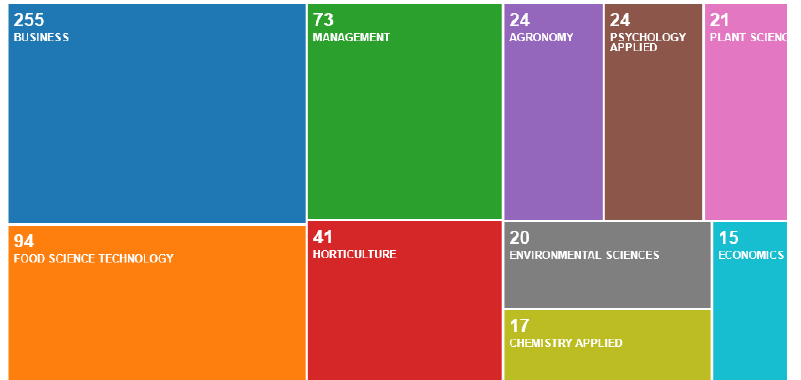
Figure 2. Treemap of literature pertaining to aromachology, showing breakdown by scientific fields (N = 617, Source: Web of Science, Clarivariate Analytics, Core collection, Search terms: see Section 2). Fields with fewer than 15 records were omitted to improve legibility.